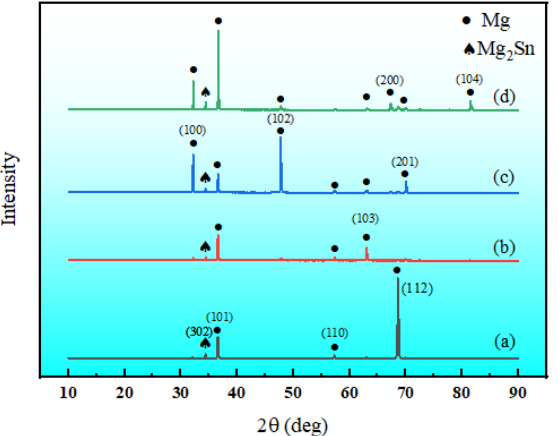
Figure 2. XRD patterns of the investigated alloys: ( a ) Mg-0.5Sn, ( b ) Mg-1Sn, ( c ) Mg-2.5Sn and ( d ) Mg-4Sn.